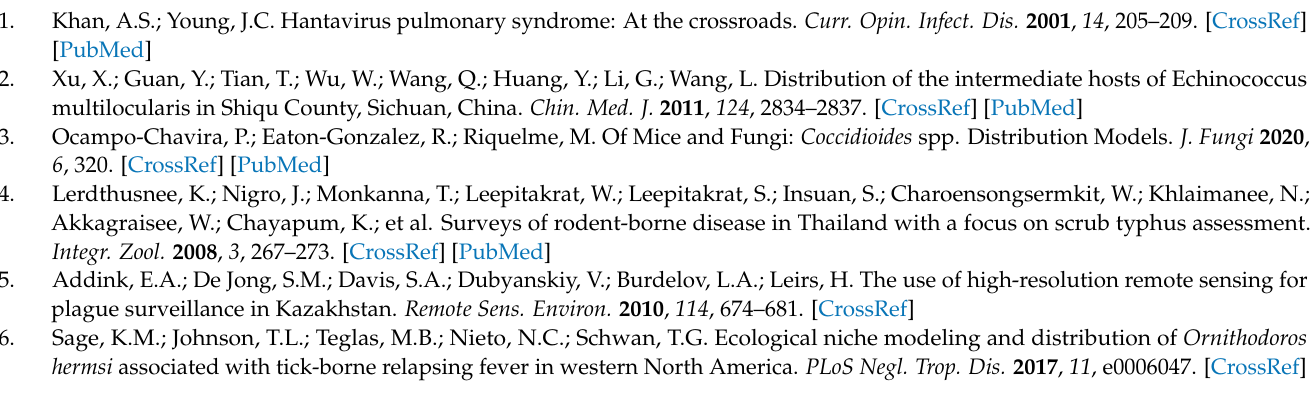
Figure S5: The response curves of the top predictor environmental variables of Maxent model- ing for Microtus (A), Citellus (B), Myospalax (C), Meriones (D), Ochotona (E); Table S1: The en- vironmental variables influencing rodent species distribution extracted from remote sensing data; Table S2: Estimates of relative importance and contributions of the environmental variables in the Maxent model for Microtus (A), Citellus (B), Myospalax (C), Meriones (D), Ochotona